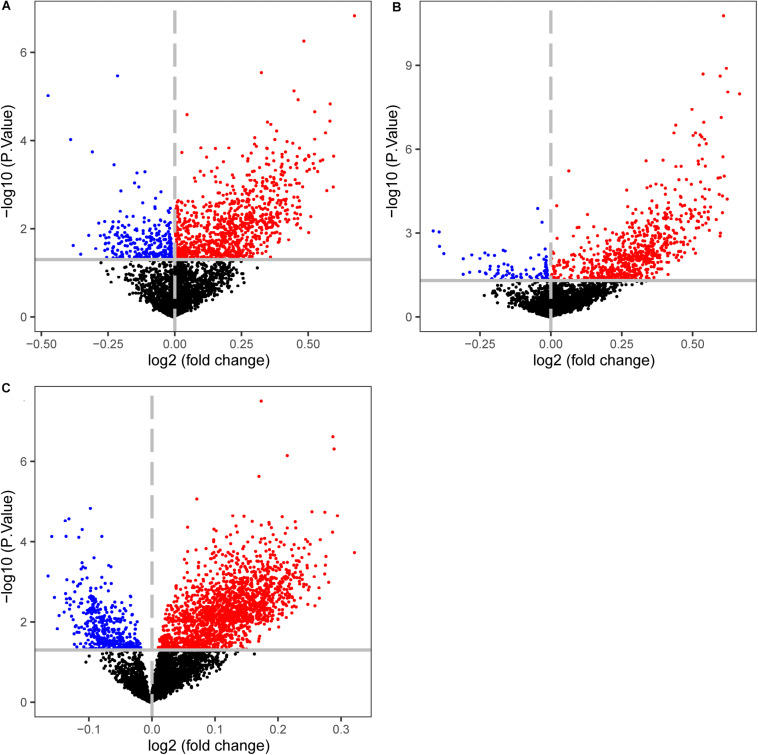
Volcano plots of the differentially methylated CpG sites between CIMP+ and CIMP− samples. (A) The samples with predicted CIMP status by 19-GPS in GSE25062. (B) The samples with original CIMP status in GSE25062. (C) The samples with predicted CIMP status by 19-GPS in GSE79740. The log2 (fold change) beta value difference in DNA methylation between the samples with CIMP+ and CIMP− status is plotted on the x-axis, and the P value (−1 × log10 P value) for limma test of differences between the two subtypes is plotted on the y-axis. The CpG sites which are significantly different and log2 (fold change) > 0 between the two subtypes are shown in red, and the CpG sites which are significantly different and log2 (fold change) < 0 are shown in blue.